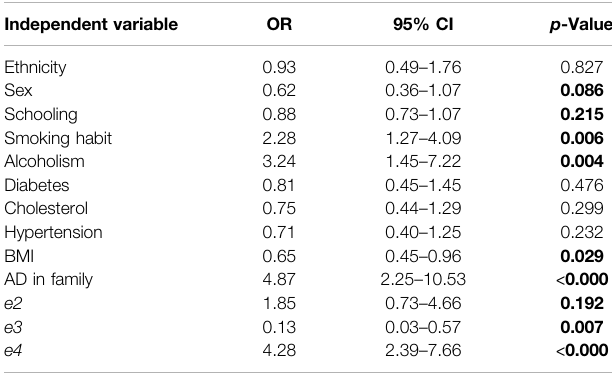
TABLE 3 | Results of univariate analysis for all available